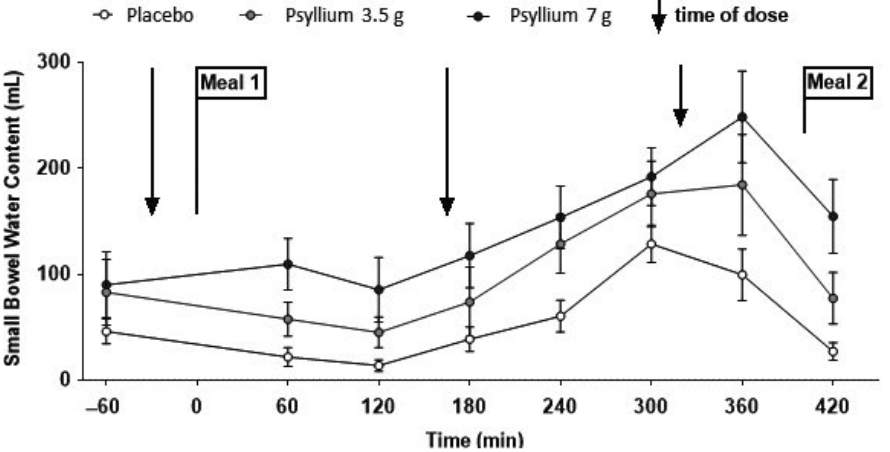
Figure 8. Small bowel water content during the study day during a RCT of psyllium 3.5 g and 7 g versus maxtodextrin 14 g three times daily (shown by arrows), showing a rise in SBWC particularly after the second and third dose. Reproduced from [32], John Wiley and Sons 2019, with permission.